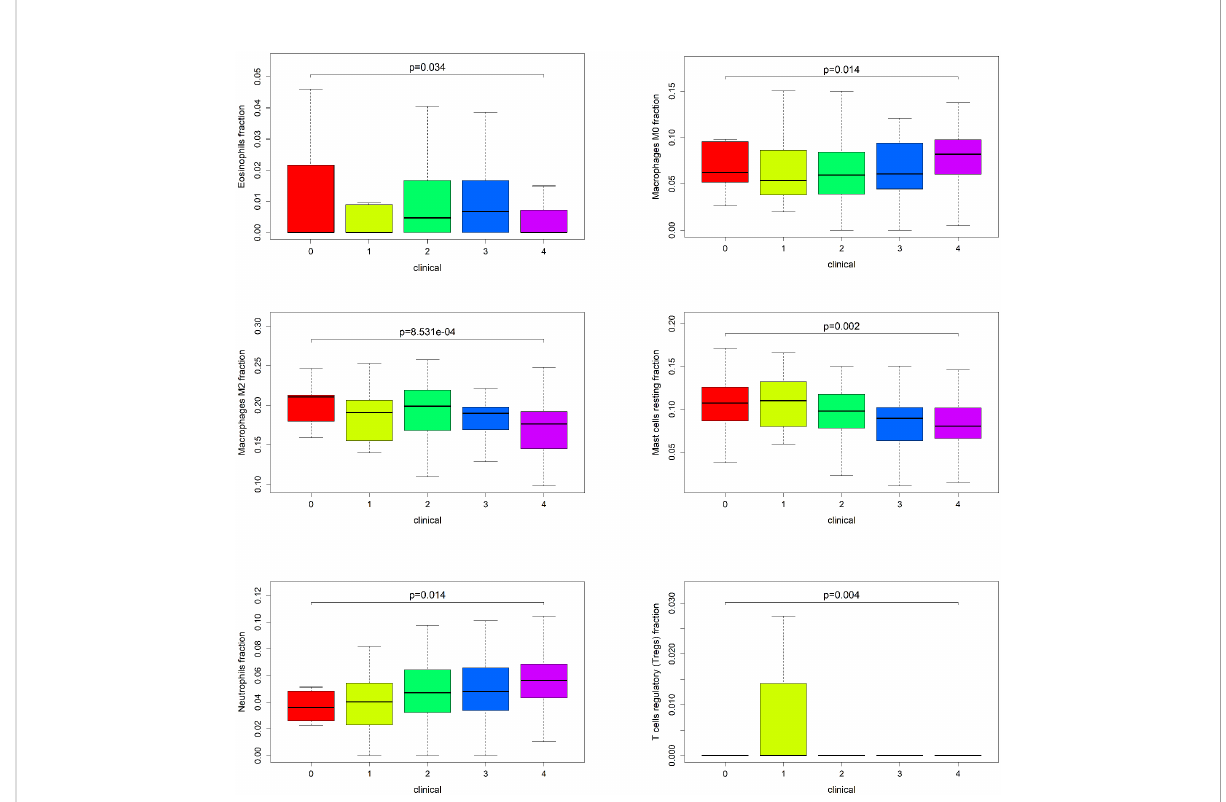
FIGURE 3 The relationship between GOLD Stage and the in fi ltration level of statistically signi fi cant (P < 0.05) tissue-in fi ltrating immune